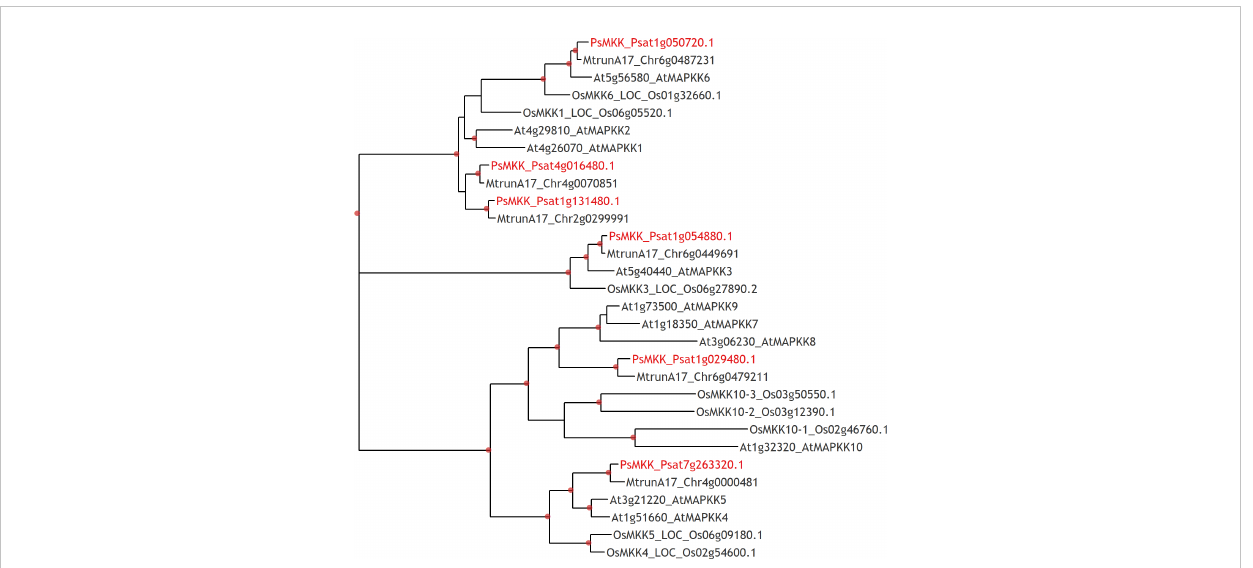
FIGURE 6 Phylogenetic tree constructed by the Maximum Likelihood method based on amino acid sequences of MAPKKs from Arabidopsis thaliana , rice Oryza sativa and legumes: Medicago truncatula , Pisum sativum . Red labels show genome identi fi ers of PsMAPKK6 (Psat1g029480), PsMAPKK2 (Psat4g016480), and PsMAPKK1 (Psat1g131480).